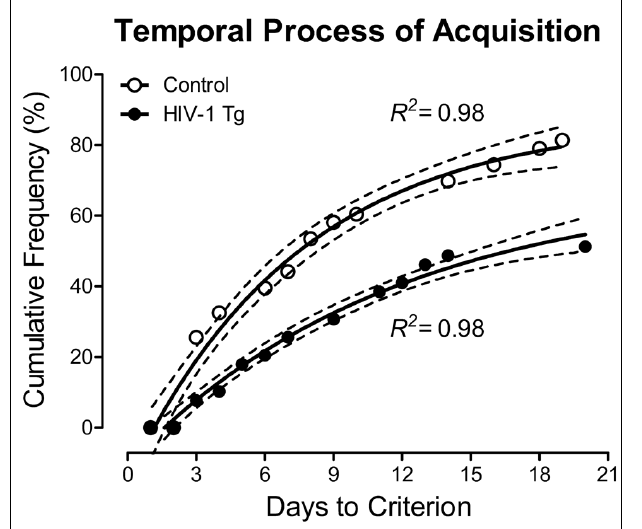
FIGURE 2 | The number of sessions required to meet criterion (70% accuracy on three consecutive sessions) is presented as a function of genotype human immunodeficiency virus (HIV-1 Tg vs. control; ± 95% CI). HIV-1 Tg animals exhibited a slower rate of task acquisition relative to control animals, supporting a deficit in stimulus-response learning.